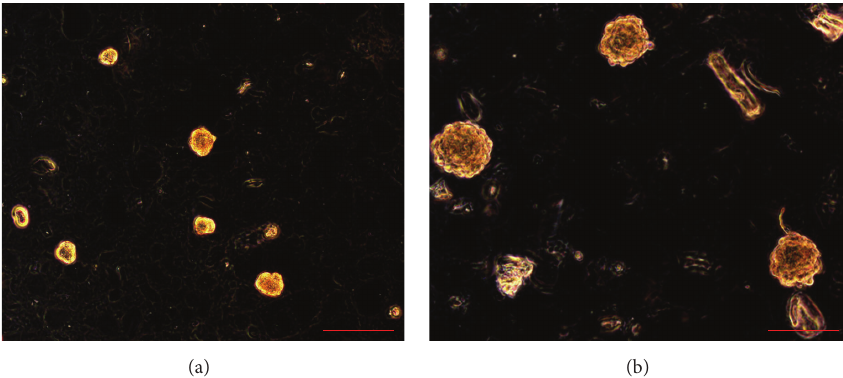
Figure 7: Sarcosphere assay on OSA3 at 14 and at 28 days. (a) After 14 days from the start of the assay, several small spherical colonies can be observed. The sarcospheres (indicated by the yellow arrows) appear floating in the medium or slightly settled down into the bottom of the well. (b) After 28 days big spherical colonies can be observed. Observation in phase contrast. Original magnification: 20x. Bar size: 100 𝜇 m.